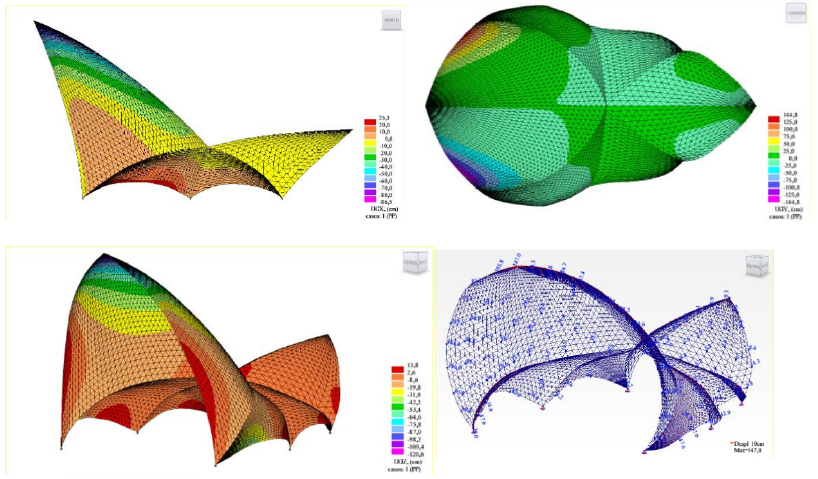
Figure 14. Node displacements under self-weight load along the global main axes X, Y, and